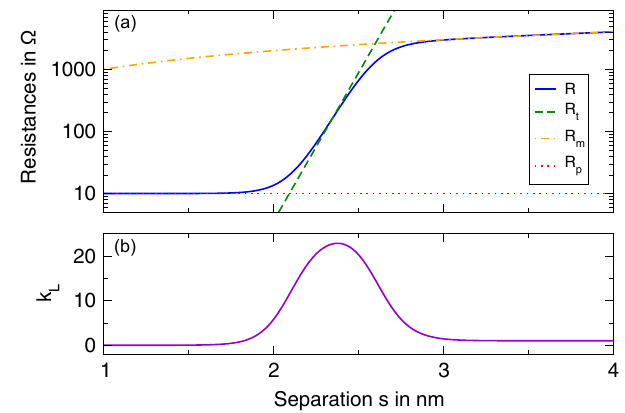
Figure 5. Analytical results for a single particle-to-particle junc- tion. (a) Total resistance R and its individual components: exponen- tial tunneling resistance R t , linear matrix material resistance R m , and the small and constant metal particle resistance R p . (b) Result- ing longitudinal gauge factor k L